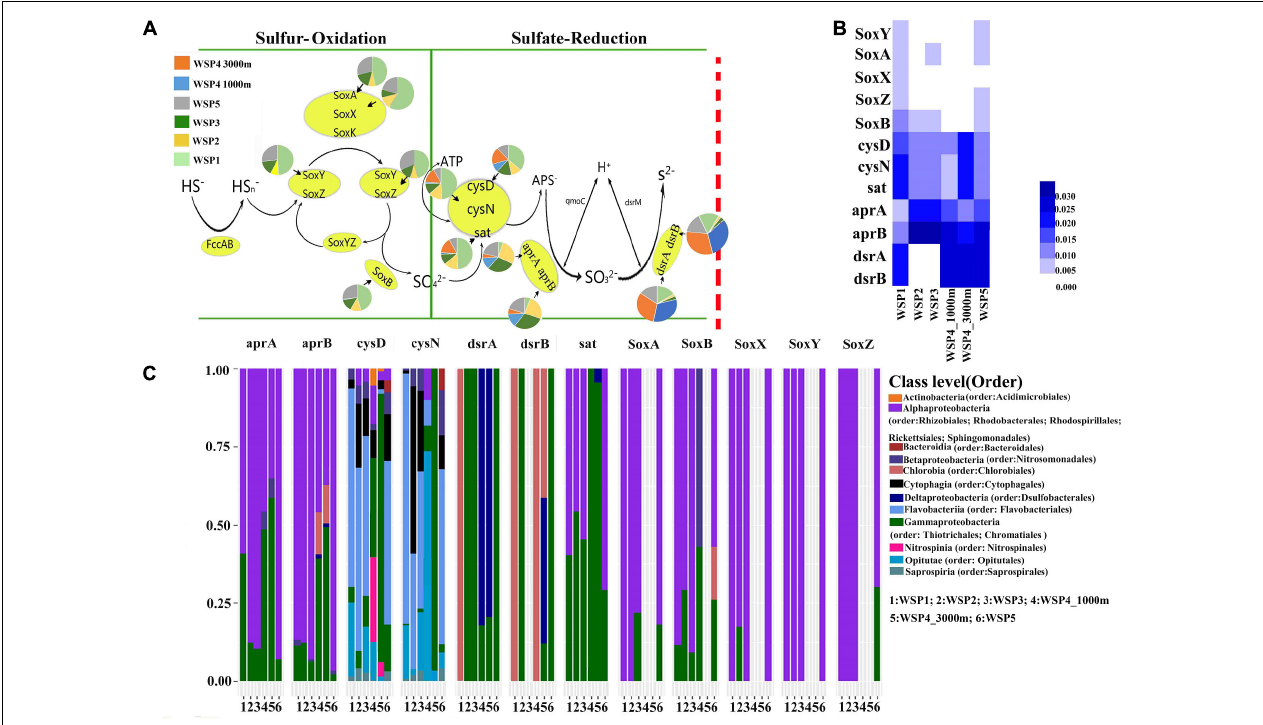
FIGURE 7 | The pie charts represent the relative abundance of sulfur metabolism related genes, which was calculated through dividing the sum of a gene’s coverage in an individual sample by the sum of this gene’s coverage in all samples (A) . The absolute abundance of each gene in each sample was calculated through dividing the coverage of an individual gene by the summed coverage of all functional genes, and the final value was squared (B) . The microbial taxa of the genes and its relative abundance in each sample (C) . The taxonomic identifications were based on the blast results of NR